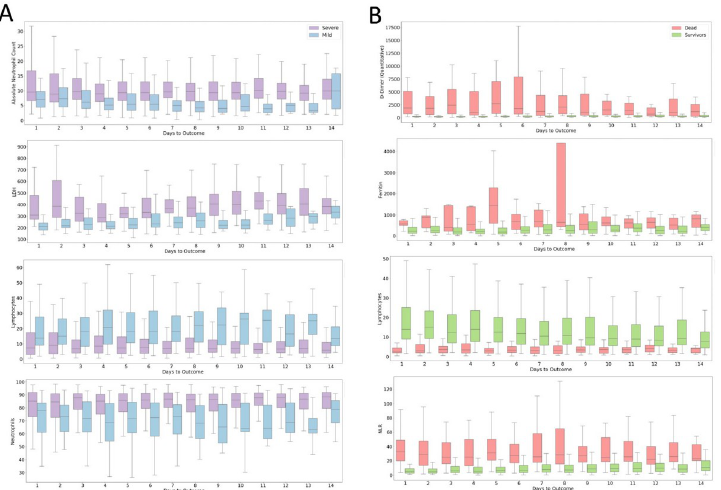
Fig 7. Biomarker variations in different patient classes in due course of disease progression by (A) risk (B) mortality parameters. Showing consistent separation of biomarker levels in mortality prediction parameters and a decrease in separation of risk prediction